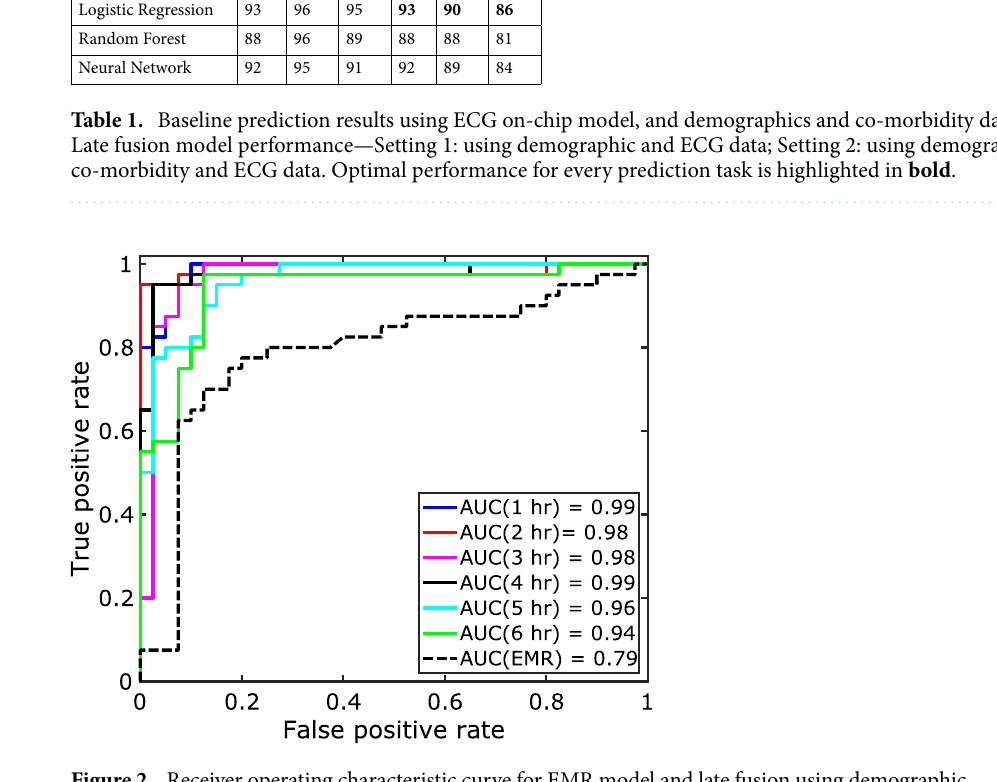
Figure 2. Receiver operating characteristic curve for EMR model and late fusion using demographic, co-morbidity, and ECG data at different time